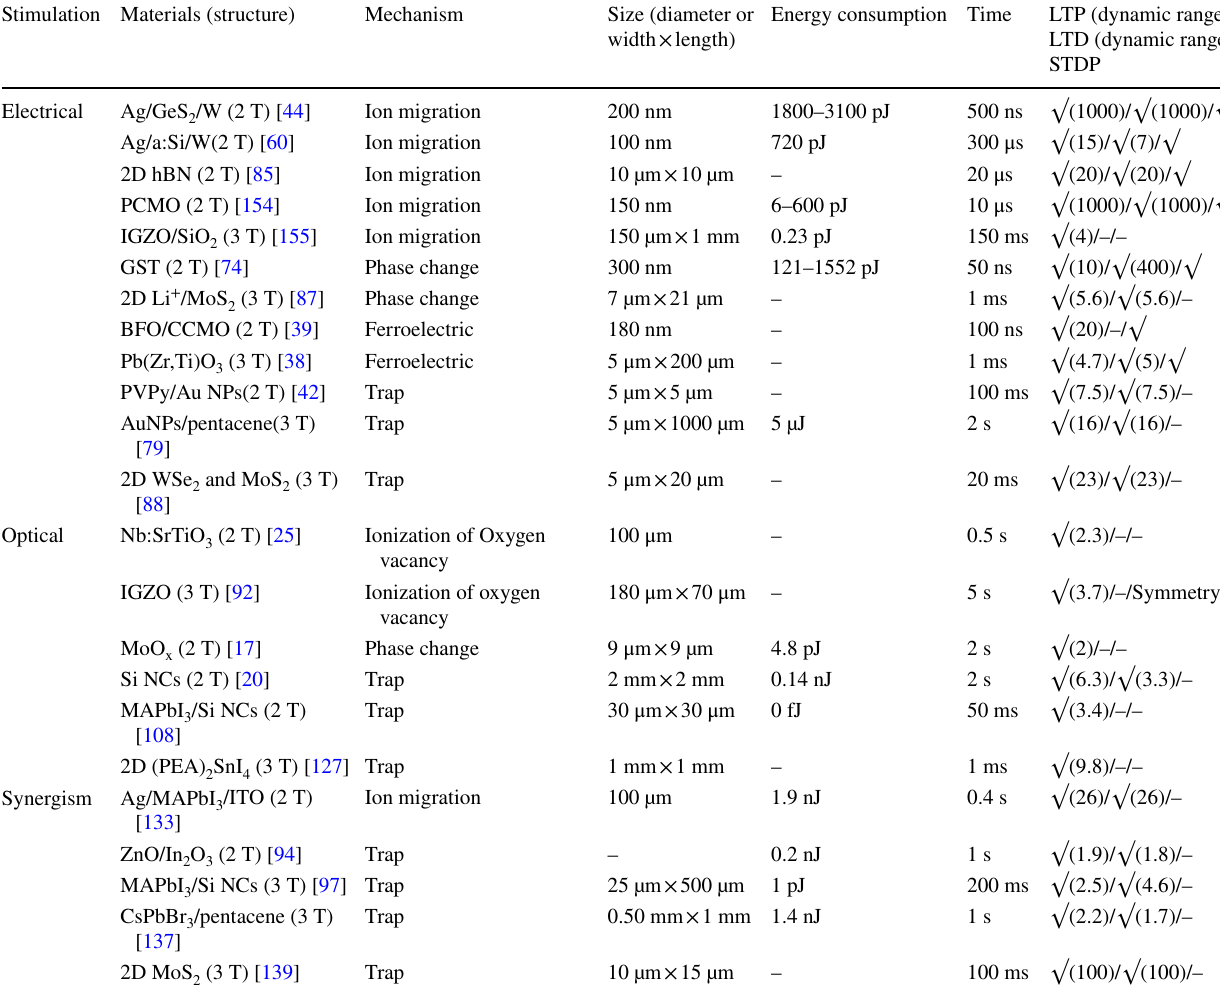
Table 1 Performance metrics of representative synaptic devices (2 T:2 terminals, 3 T:3 terminals) Stimulation Materials